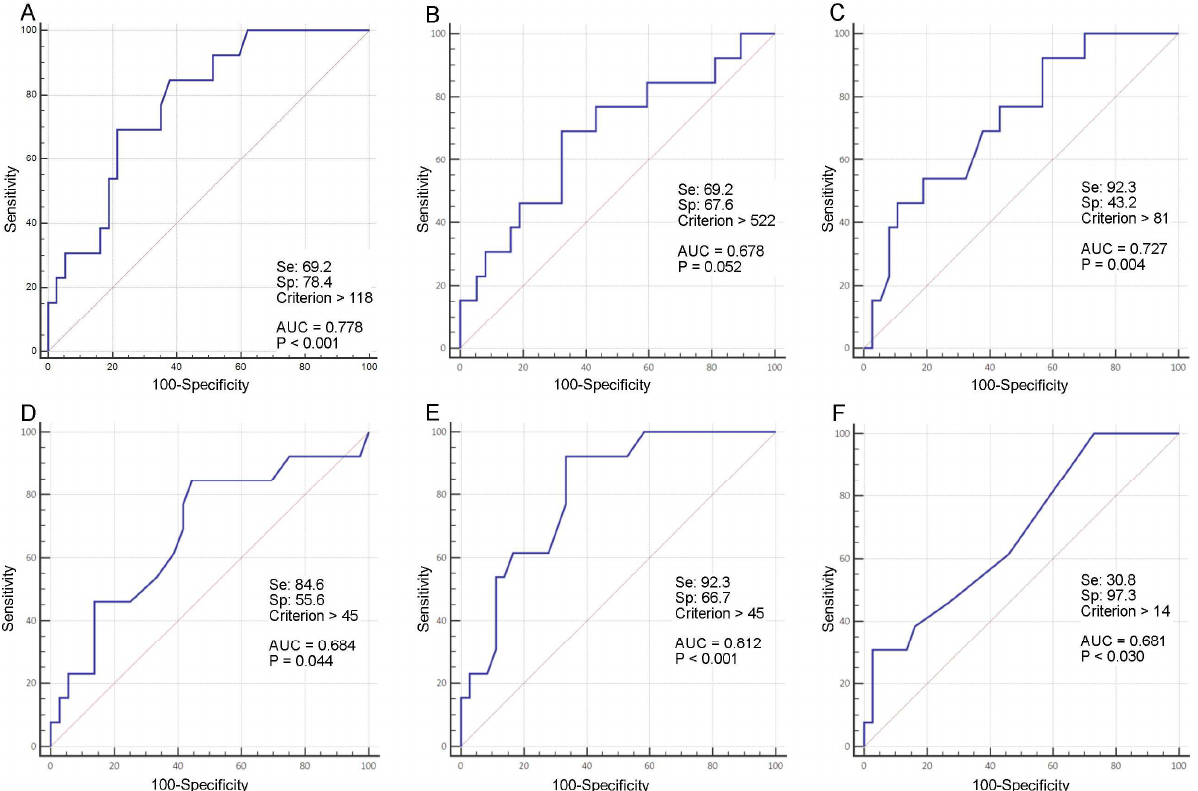
Figure 1. Predictive ROC curves for Fall (1) and NFall (0) subjects. ( A ) Max_Speed_Oscillation OE; ( B ) Path length at OE; ( C ) Sway area at OE; Right ( D ) and left ( E ) anterior-posterior (AP) ground reaction force (GRF); ( F ) TUG duration. AUC = Area Under the Curve; Criterion = Youden’s Index; OE = open eyes; SE = sensitivity; SP = Specificity; TUG = timed up and go test.